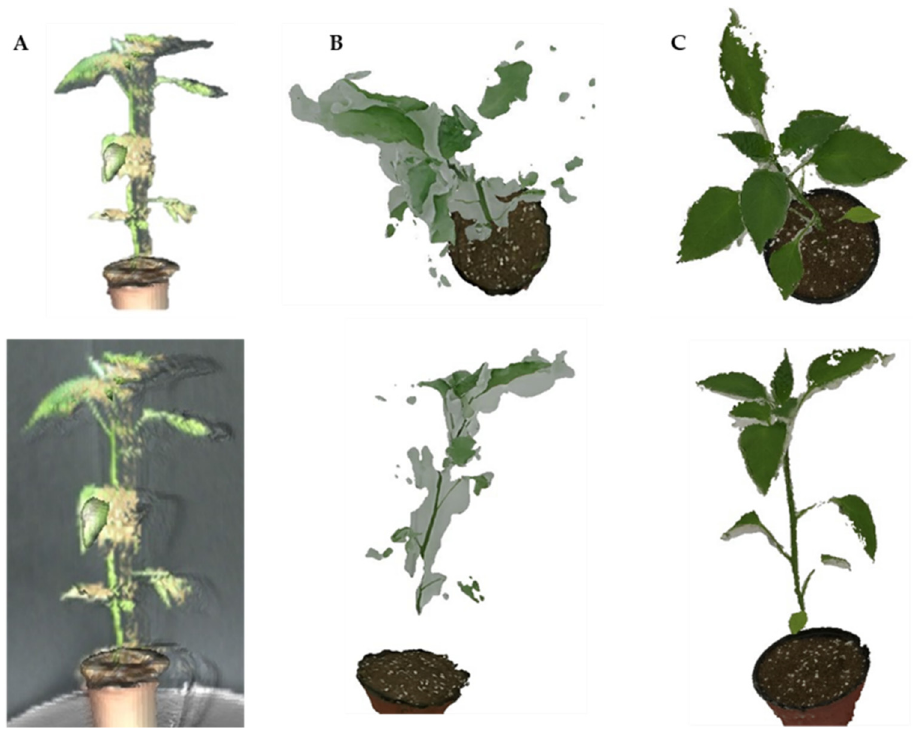
Figure 5. 3D reconstruction results. ( A ) Kinect fusion explorer, ( B ) Kinect low-resolution color image, and ( C ) high-resolution RGB images.